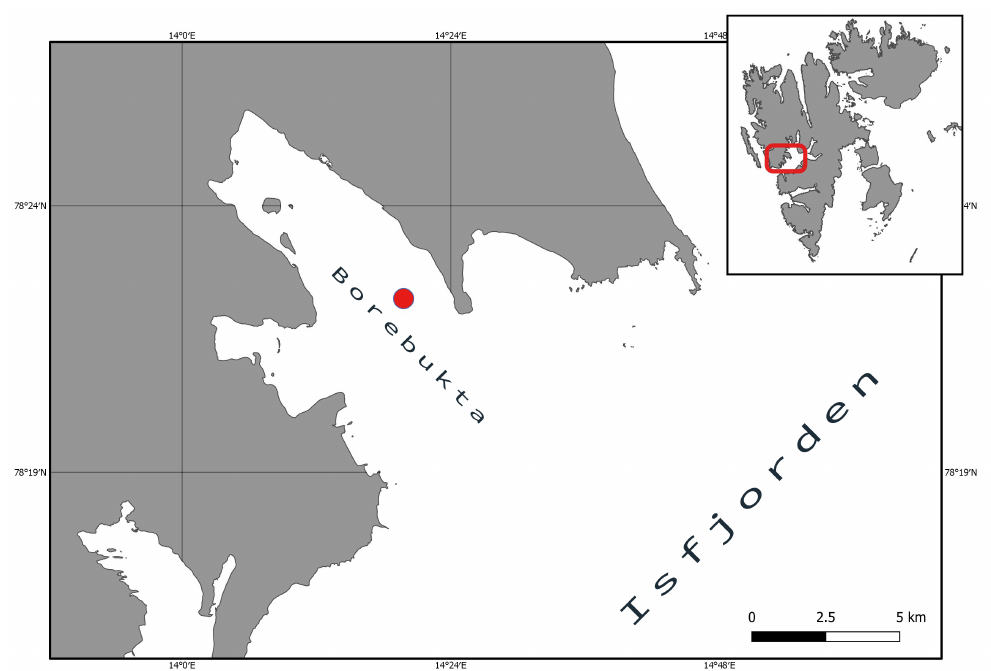
Figure 1. Map of the study area where the seabed imagery was collected. Borebukta bay on Spitsbergen Island, Svalbard